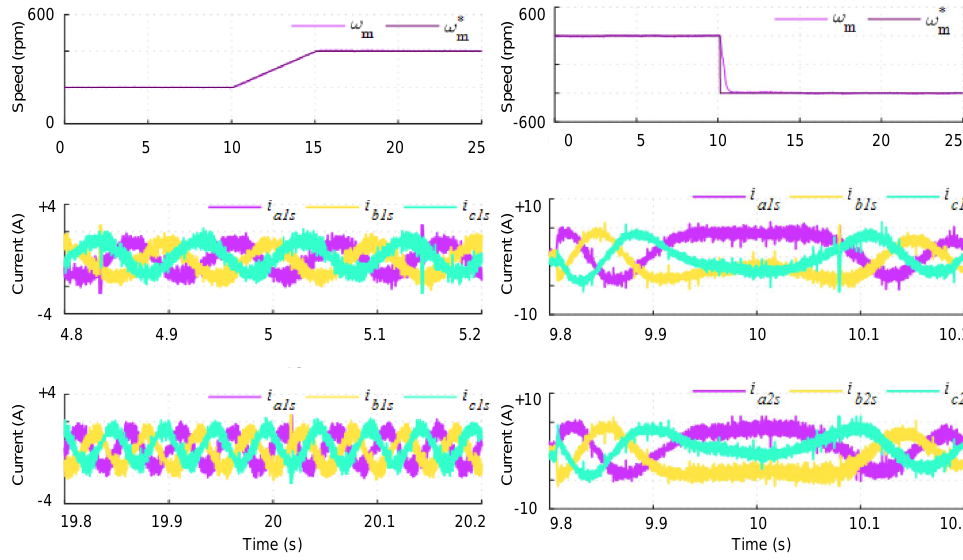
Figure 11. Trajectories of speed and currents for a ramp test ( left ) and a speed reversal test ( right